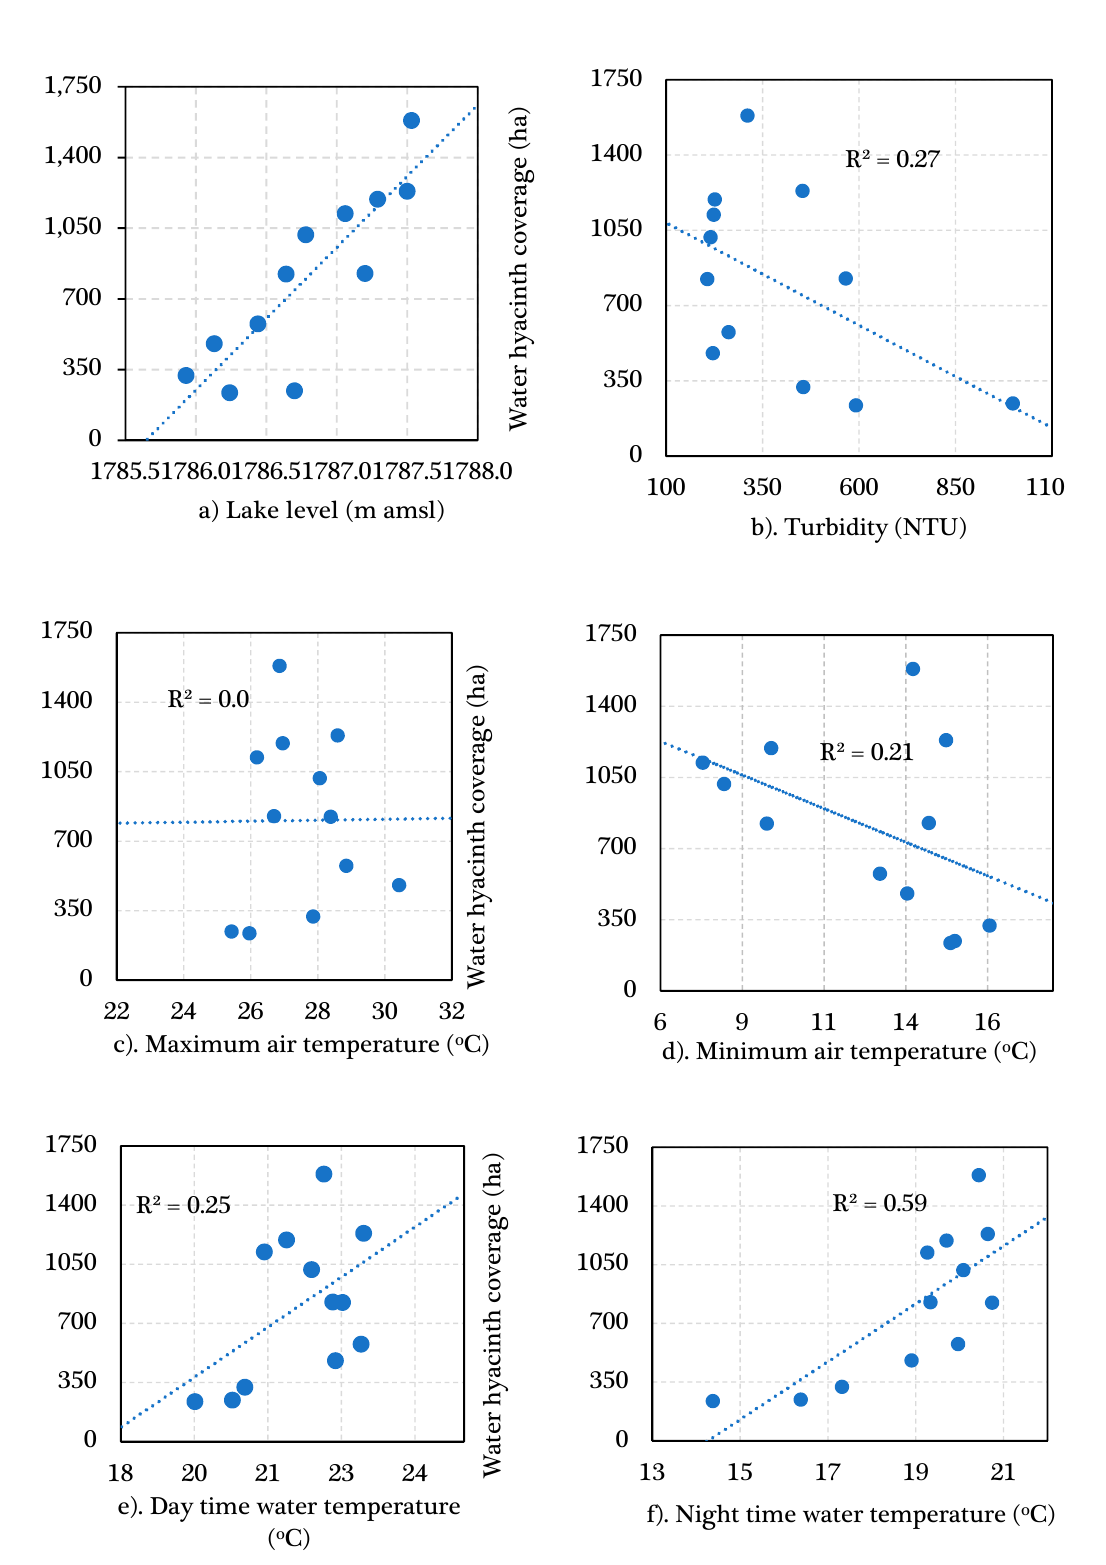
Figure 14. Correlation between water hyacinth spatial coverage and the environmental factor.